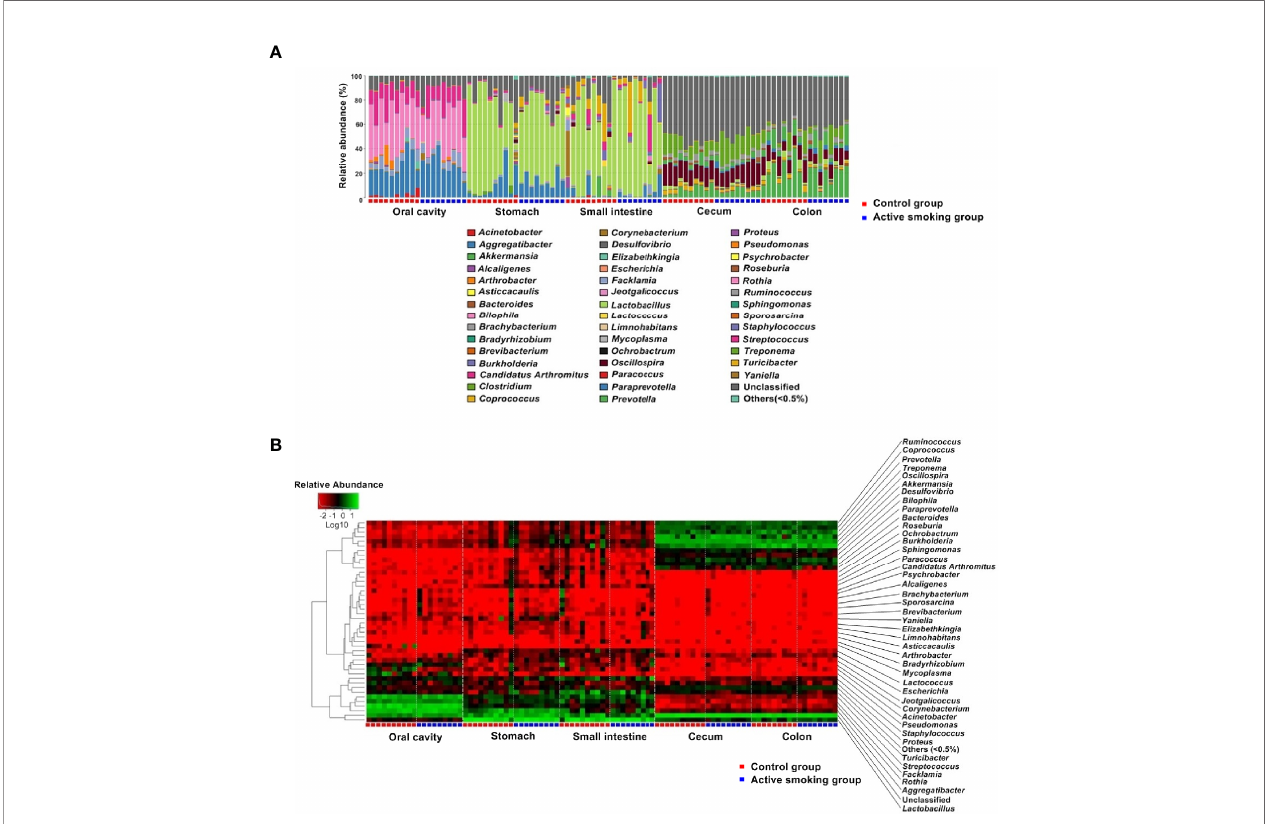
FIGURE 6 | Comparison of the microbiotal composition along the rat digestive tract between the control group and active smoking group. (A) Distribution of bacterial genera and their relative abundance among microbiota in different samples are shown in a bar plot. (B) Heatmap showing log10-transformed relative abundances of bacteria in different samples at the genus